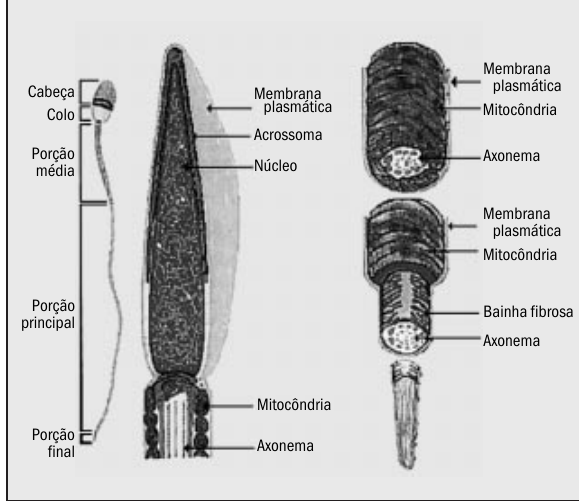
Espermatoz(cid:151)ides Figura 2 – Morfologia do espermatozóide: A. microscopia ótica; B. microscopia eletrônica – segundo Myles